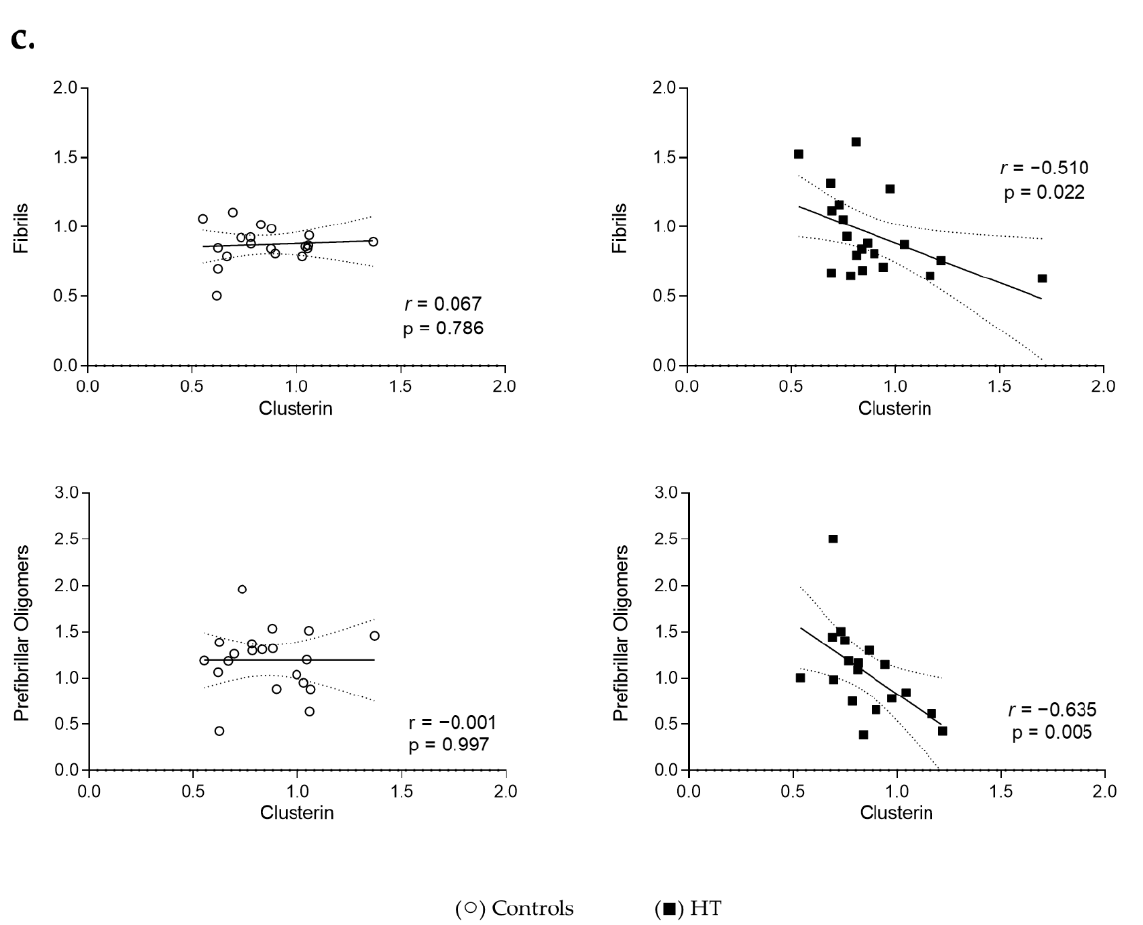
Figure 4. Association of hypertension and proteostasis-related proteins with protein aggregates. Plasma levels of Endothelin 1 ( a ) and Ubiquitin ( b ) and Clusterin ( c ) were matched with the cor- responding individual levels of fibrillar or prefibrillar proteins and peptides in controls ( individuals with hypertension ( (cid:4) ). Spearman’s rank coefficient was applied to test the strength and direction of the relationships between the different variables. The resulting coefficients (r) and corresponding p -values (p) are represented. p < 0.05 was considered statistically significant. All samples were normalized to the reference sample and protein levels are represented as fold changes relative to this reference sample. Lines represent a linear regression fit with corresponding 95% confidence bands (dotted